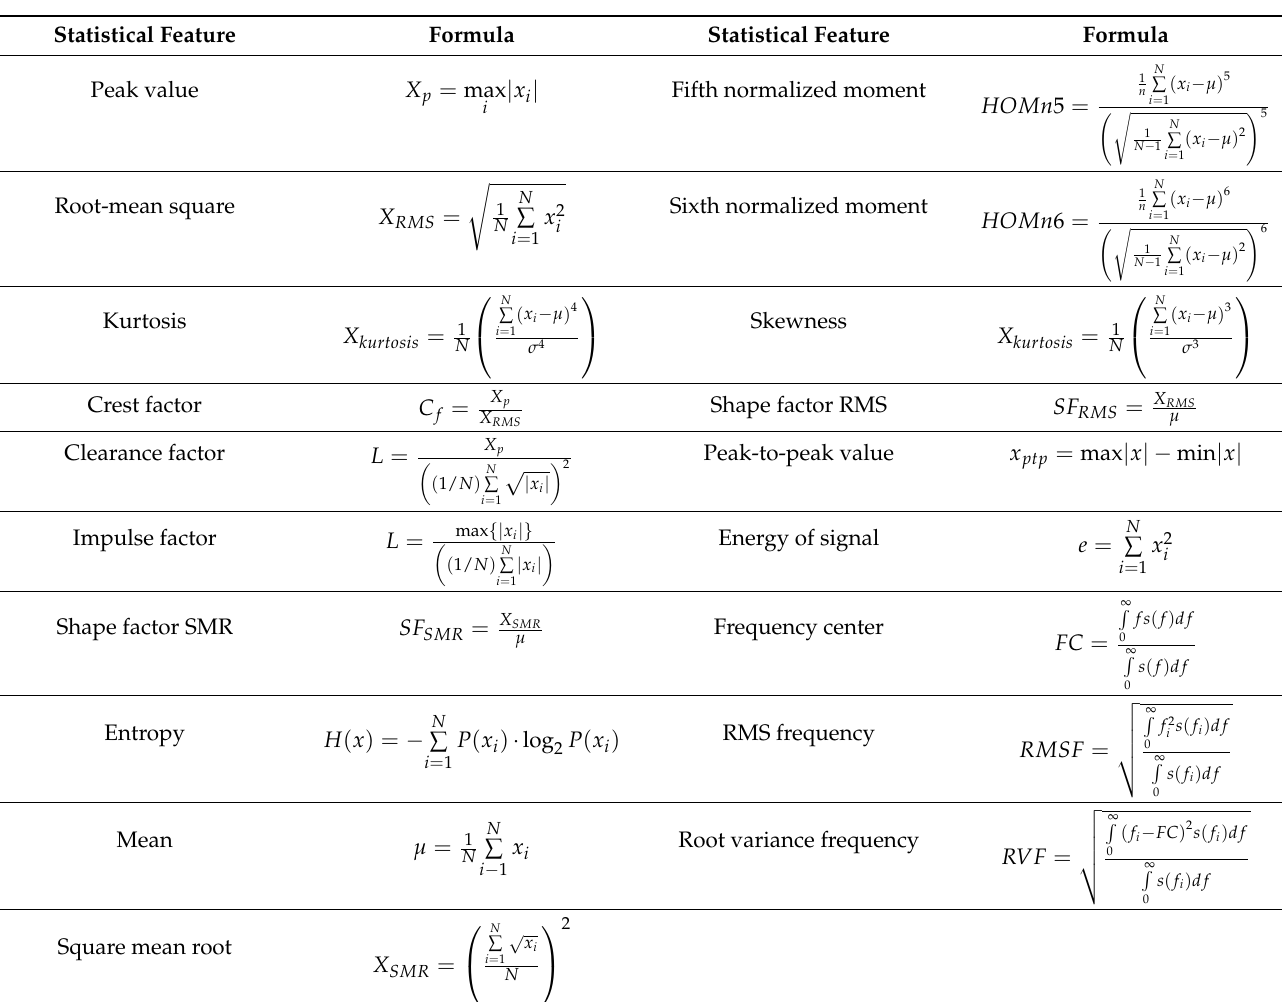
Table 5. Formulas of statistical features extracted from the vibration